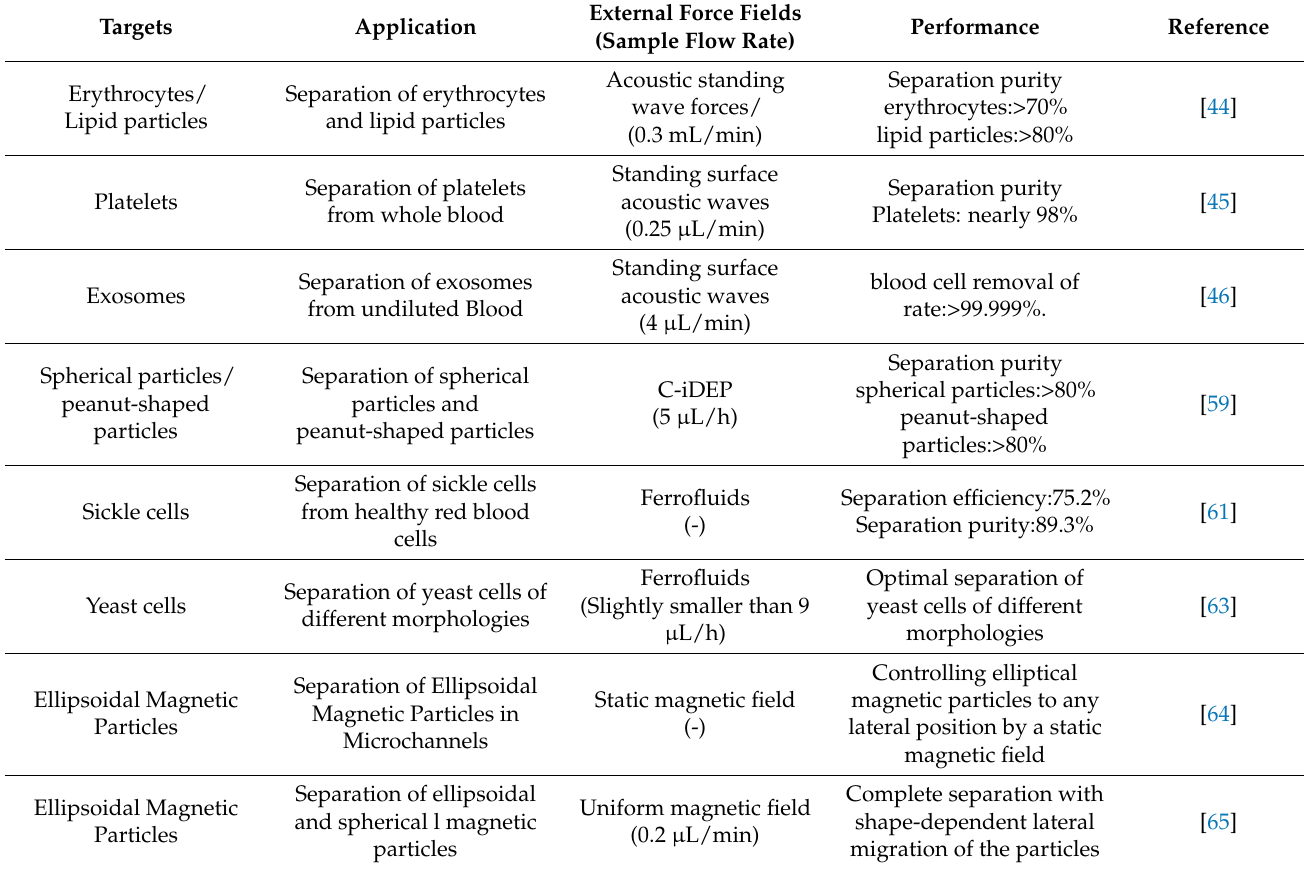
Table 1. Recent advances in active manipulation of non-spherical particles under external force fields.